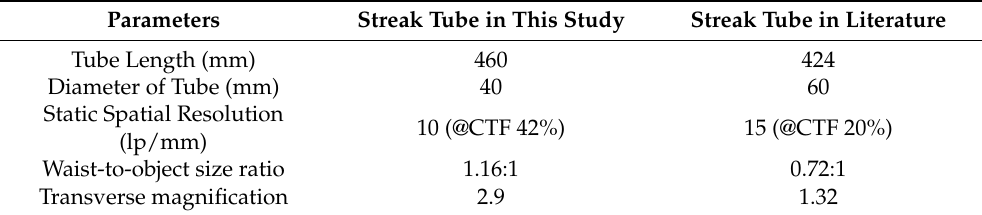
Table 3. Comparison of the imaging performance of the streak tube.